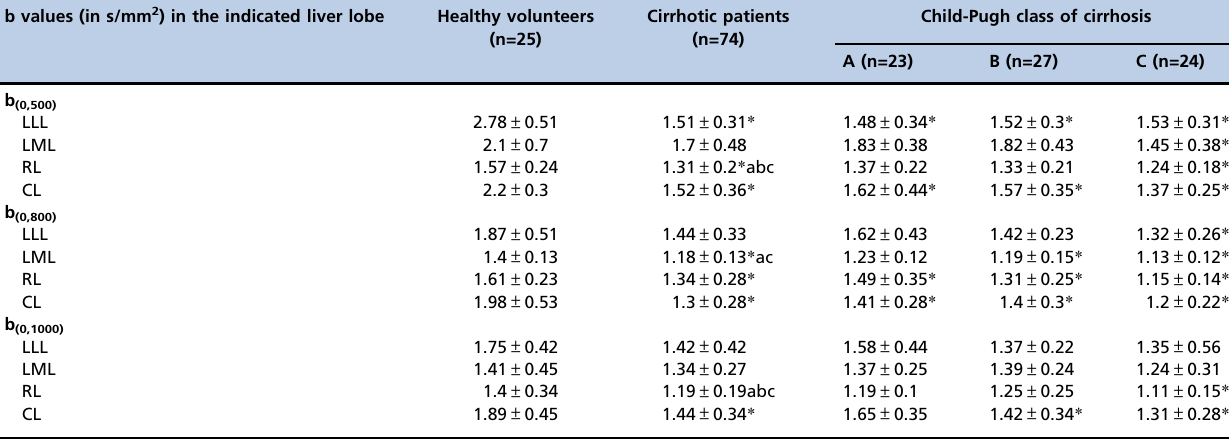
Table 2 - Liver lobe-based ADCs ( (cid:1) 10 -3 mm 2 /s) in healthy volunteers and patients with cirrhosis of different Child-Pugh classes (mean ± standard deviation). b values (in s/mm 2 ) in the indicated liver